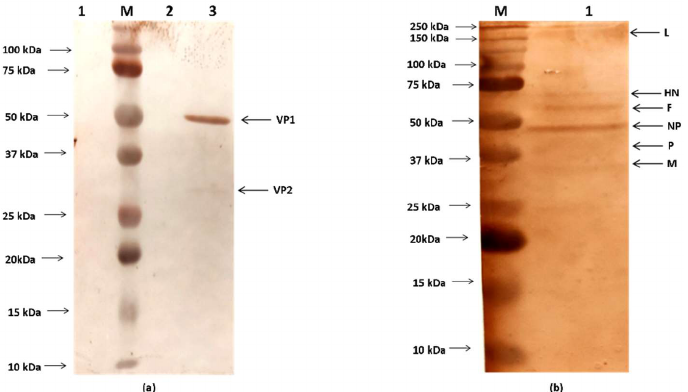
Figure 3. Western blot analysis of the purified recombinant NDV containing VP2/VP1 gene of CIAV.